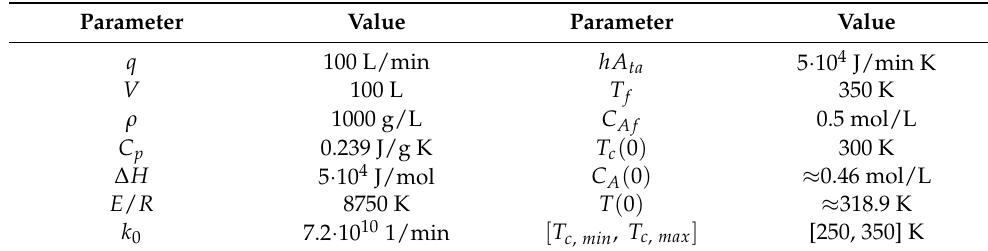
Table 1. The considered nominal values for the parameters of the CSTR plant.